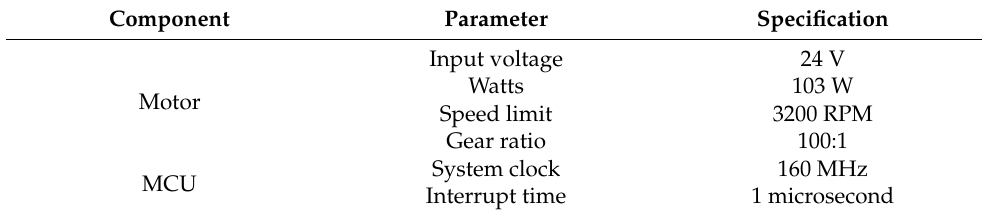
Table 5. Parameters of the experimental setup.